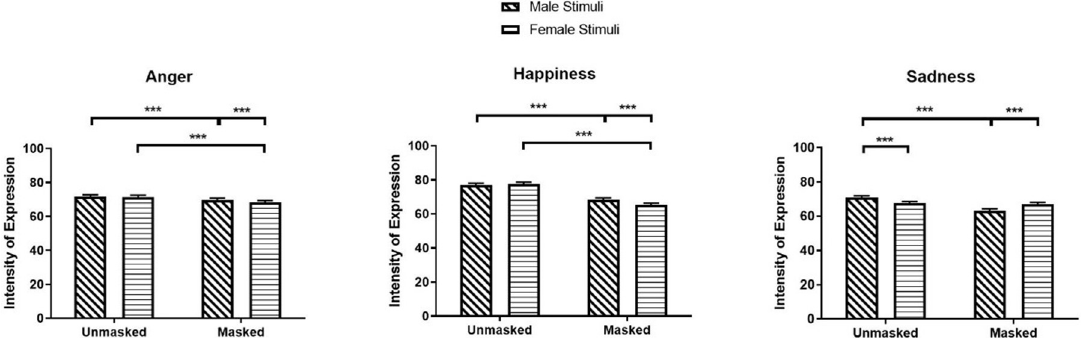
Fig 5. Intensity of expression ratings for anger, happiness, and sadness as a function of mask and stimuli sex. � p < 0.05, �� p < 0.01, ��� p <